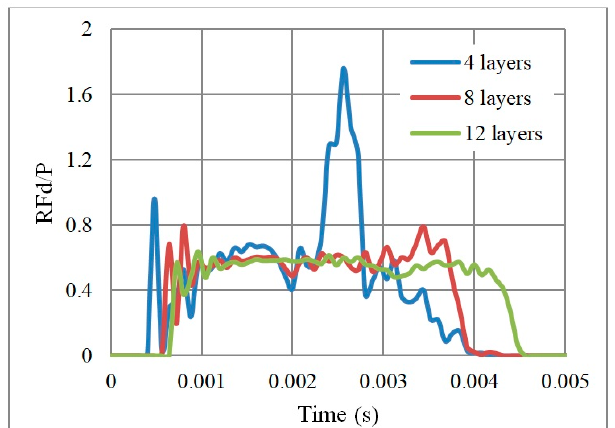
Figure 20. RFd/P with respect to time, of 3 auxetic cores with different number of layers of the same geometrical properties and loading conditions, having the same loading direction D1, Grade AL3, Cell dimension B (L = 10 mm), t = 2.6 mm, t / L = 0.26, θ Aux = 60 ◦ .